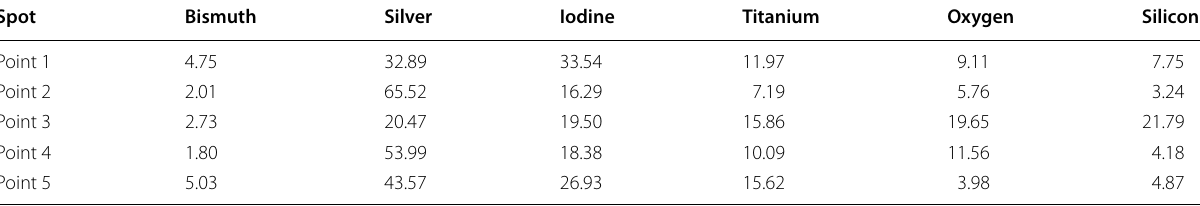
Table 8 Elemental distribution (atomic %) of the individual elements observed on a particular spot on Ag strate shown in Fig.